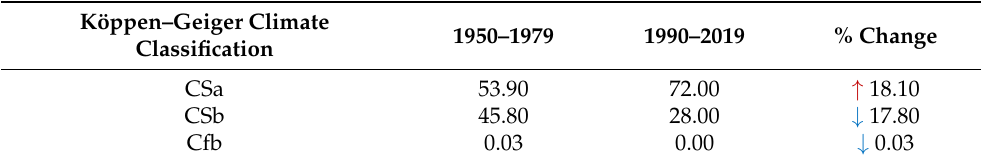
Figure 3. Köppen–Geiger climate classification for ( a ) 1950–1979 and ( b ) 1990–2019. Table 5. Percentage of the territory (in %) for each Köppen–Geiger climate classification for mainland Portugal for 1950–1979 and 1990–2019.